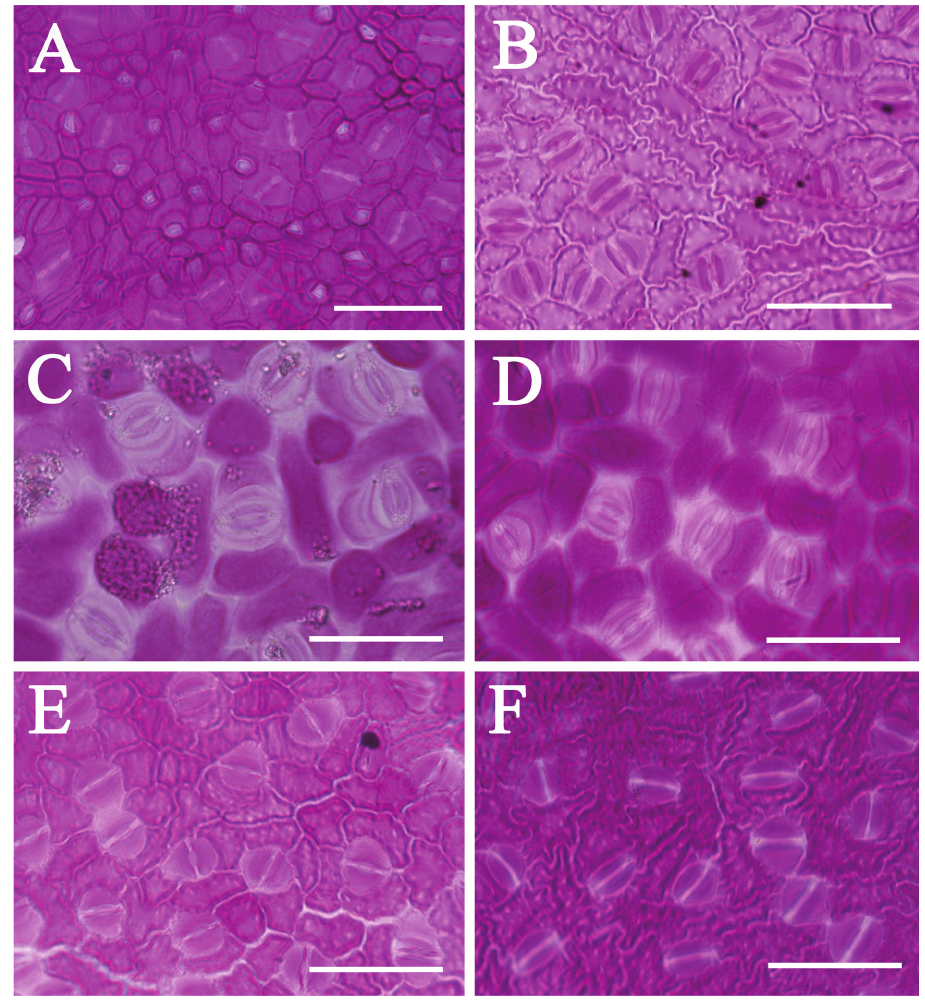
Figure 7. Lower leaf epidermis of Cinnamomum under light microscope (LM) A C. daphnoides displaying butterfly-shaped stomata B C. burmannii displaying butterfly-shaped stomata C C. migao displaying narrow lip-shaped stomata D C. longepaniculatum displaying bat-shaped stomata E C. randaiense displaying narrow lip-shaped stomata F C. verum displaying wide lip-shaped/wide lip-shaped stomata. Scale bars: 50